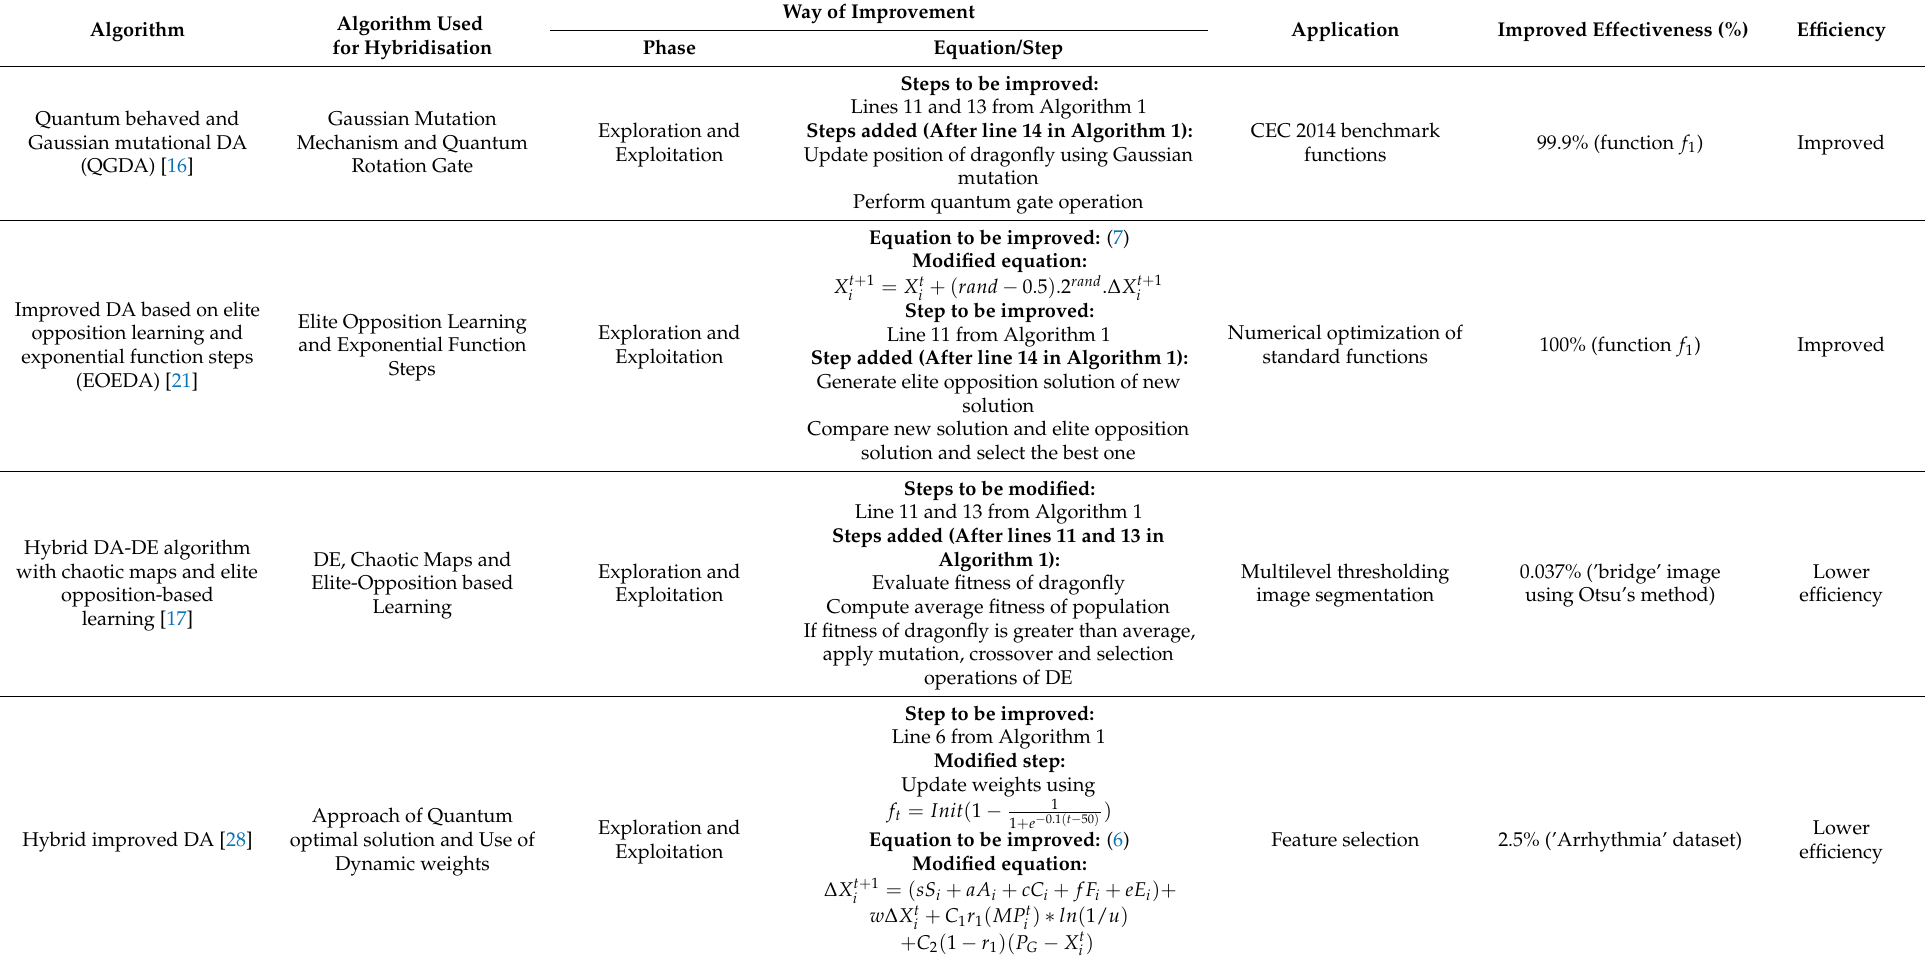
Table 4. Hybrids of DA which improves its effectiveness by improving both exploitation and